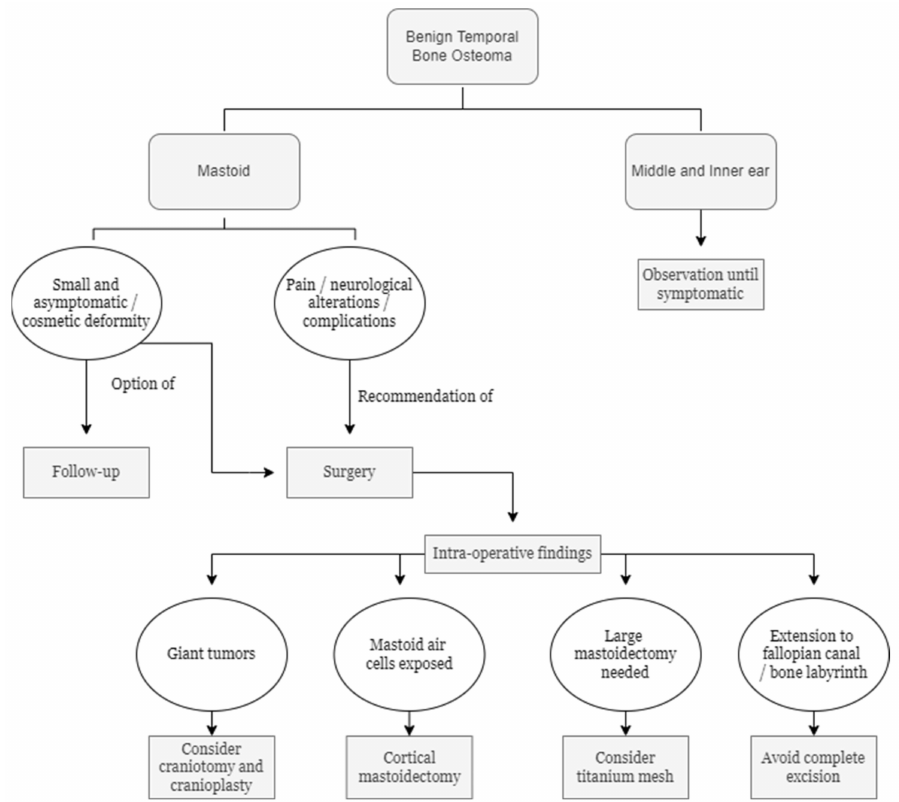
Figure 4. Temporal bone osteomas: decisional